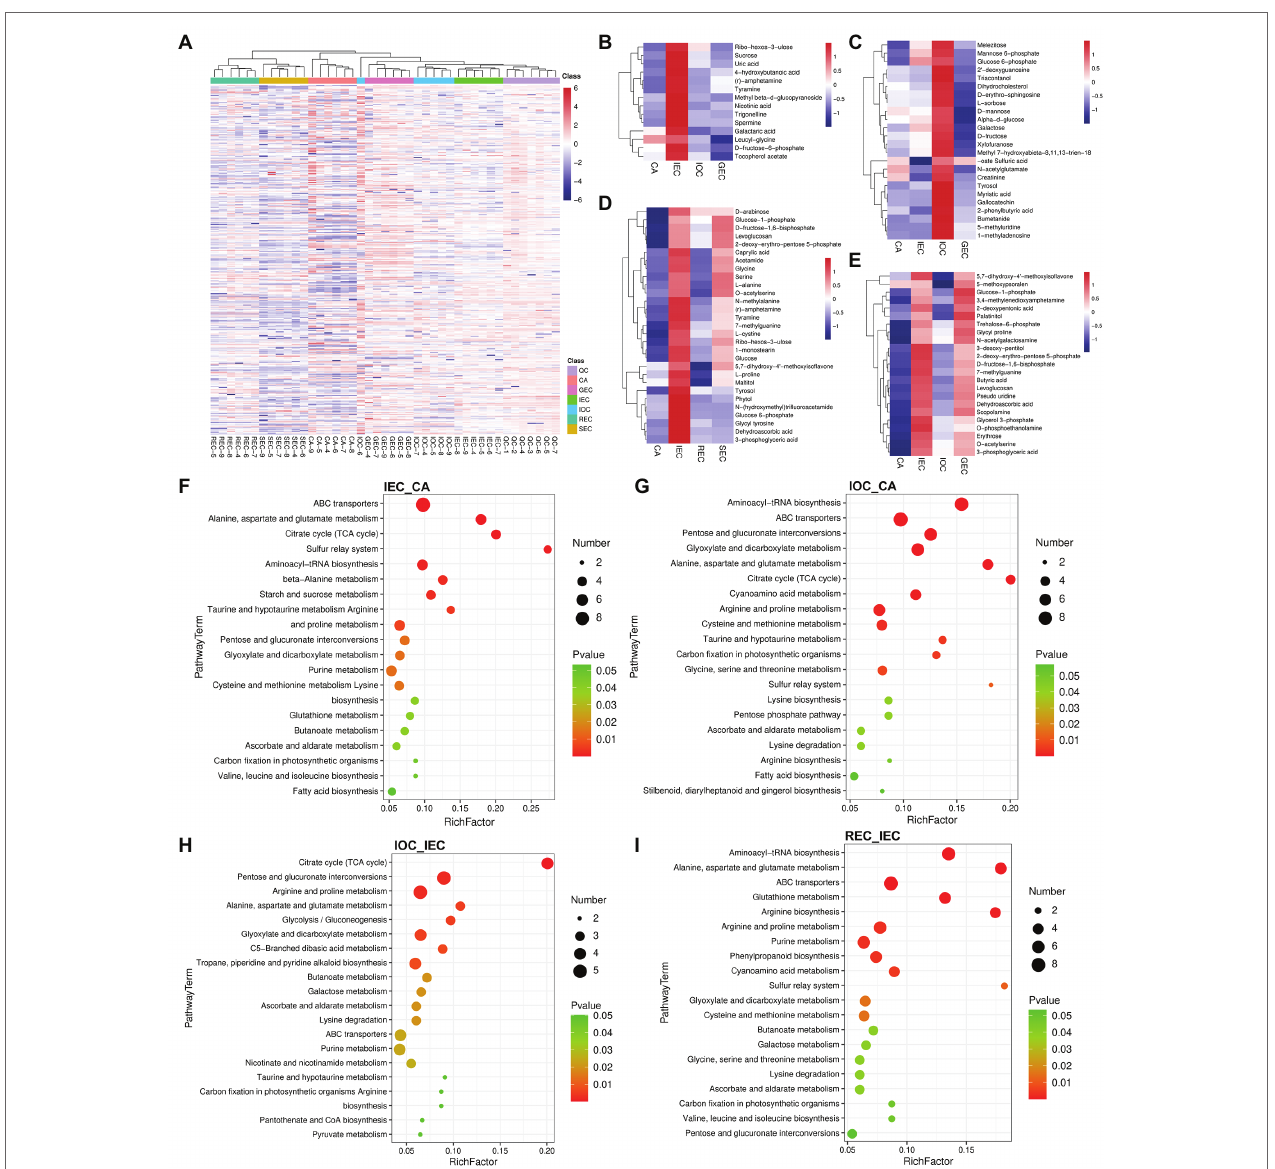
FIGURE 4 | Hierarchical clustering analyses and comparison of DAMs in the direction and stage of cell differentiation in A. praecox . (A) HCA among samples. The horizontal axis represents the sample clusters, and colors from blue to red indicate metabolite accumulation from low to high, the same below. (B) HCA of DAMs concerning CA differentiation direction, and the cluster showed DAMs with higher accumulation in IEC. (C) HCA of DAMs concerning CA differentiation direction, and the cluster showed DAMs with higher accumulation in IOC. (D) HCA of DAMs concerning CA differentiation stage. (E) HCA of DAMs concerning CA differentiation direction. (F) KEGG pathway enrichment of the comparison of IEC/CA. The bubble size represents the number of members detected in the KEGG pathway, and the color of the bubble represents the p -value, the same below. (G) KEGG pathway enrichment of the comparison of IOC/CA. (H) KEGG pathway enrichment of the comparison of IOC/IEC. (I) KEGG pathway enrichment of the comparison of